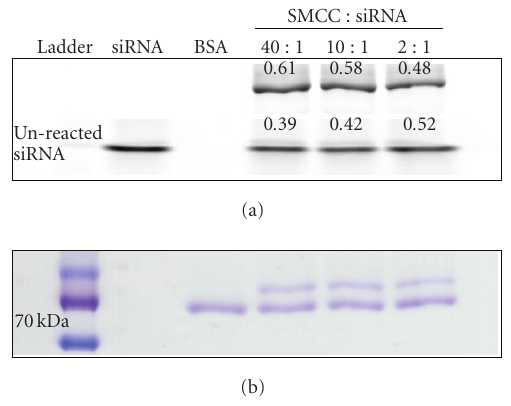
Figure 4: SMCC :siRNA ratio can be reduced without loss of yield after ultrafiltration of amine-modified siRNA. Conjugation of amine-modified siRNA with BSA using 40 :1, 10: 1, and 2 :1 SMCC-to-siRNA molar ratios. Conjugates formation was observed for each of the SMCC: siRNA ratios; reducing the ratio from 40: 1 to 2:1 had relatively little e ff ect on conjugate yield. siRNA std :siRNA standard; BSA std :BSA